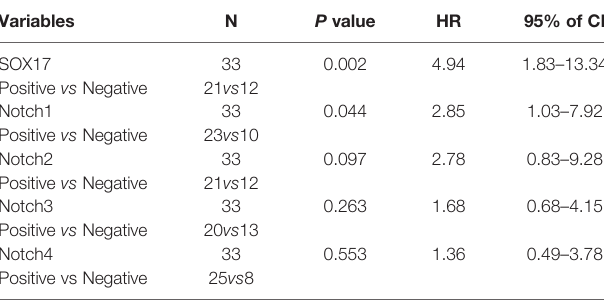
TABLE 2 | Multivariate Cox analysis for PFS of CRPC